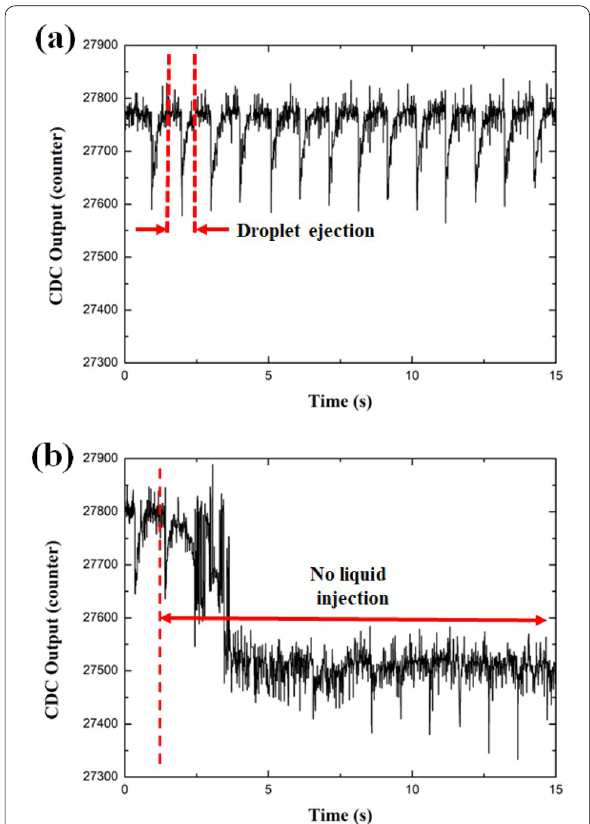
Fig. 8 Measured sensor signal under a the normal and b abnormal ejecting